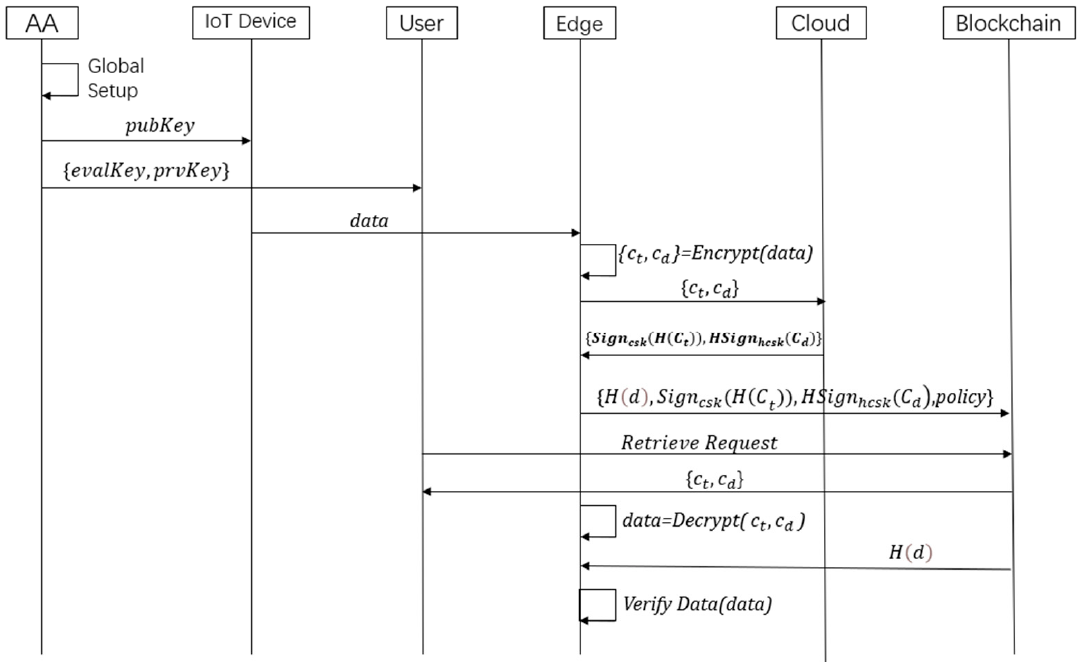
Figure 2. Data storage and retrieval process.